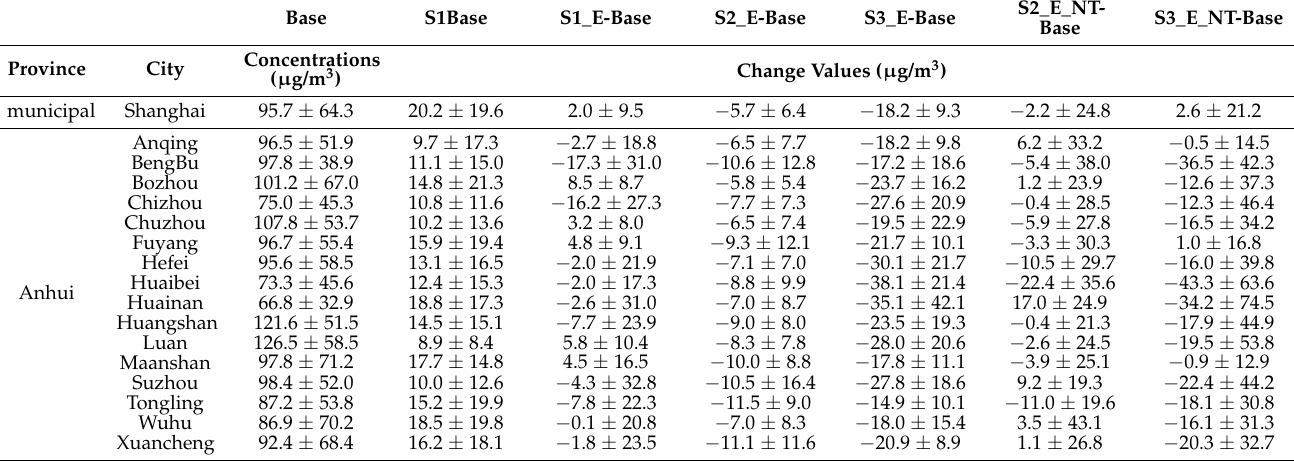
Table 5. Predicted average change values of summer MDA8 O 3 concentrations under the 6 control scenarios relative to the baseline in 41 main cities of YRD in 2025. The results of the base case are also